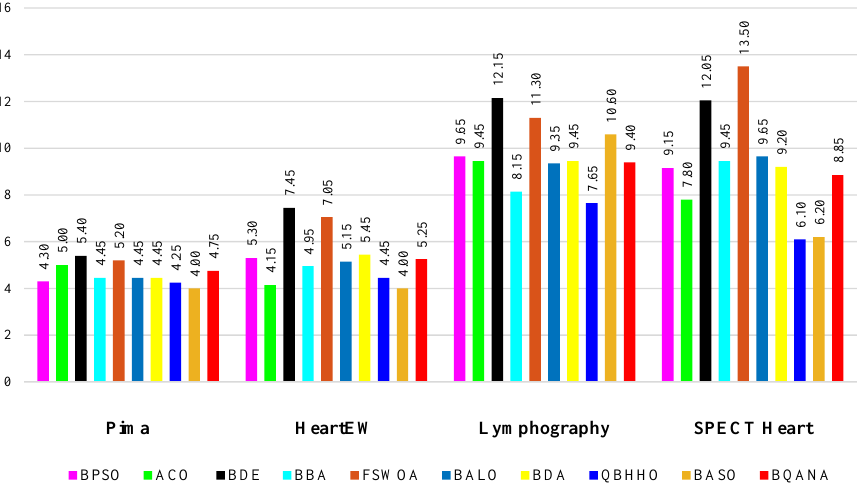
Figure 6. The average number of features selected by BQANA and comparative algorithms on small datasets.